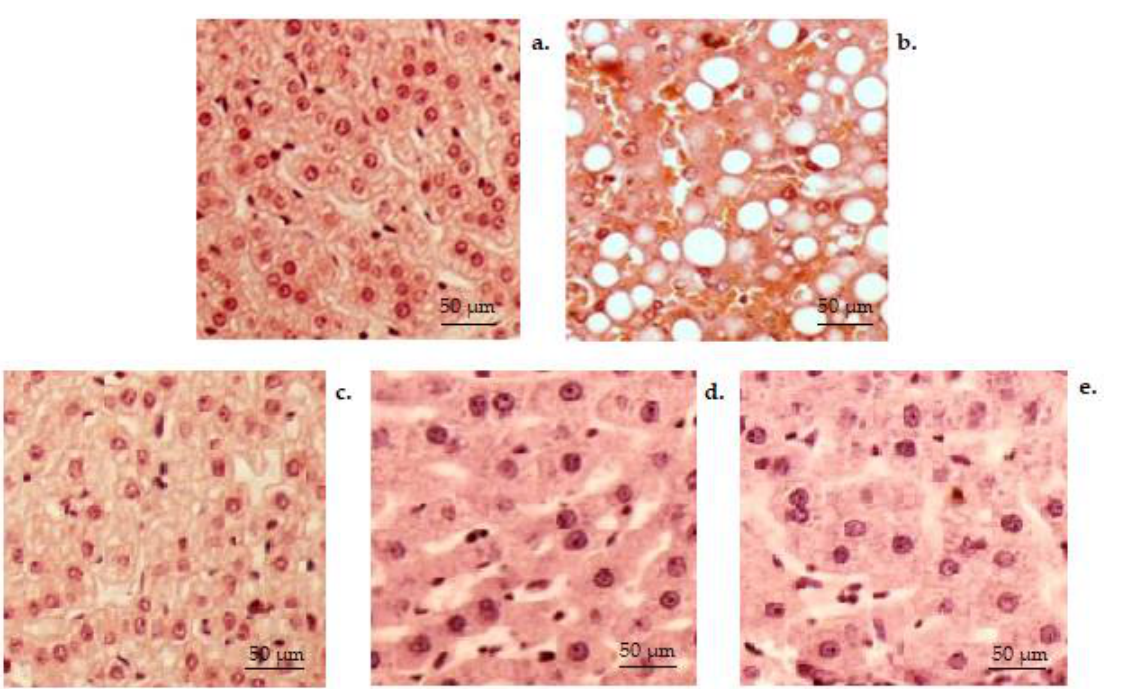
Figure 9. Histopathological images of the hepatic architecture in the control ( a ), control alcohol ( b ), CHIT ( c ), CHIT-ves ( d ) and AcA ( e ) groups (H&E stain × 20).